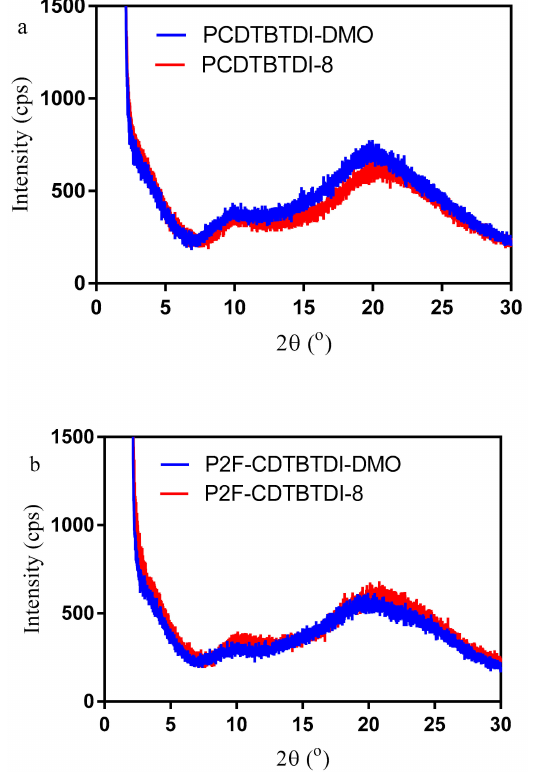
Figure 4. Powder XRD of ( a ) PCDTBTDI-DMO and PCDTBTDI-8; ( b ) P2F-CDTBTDI-DMO and